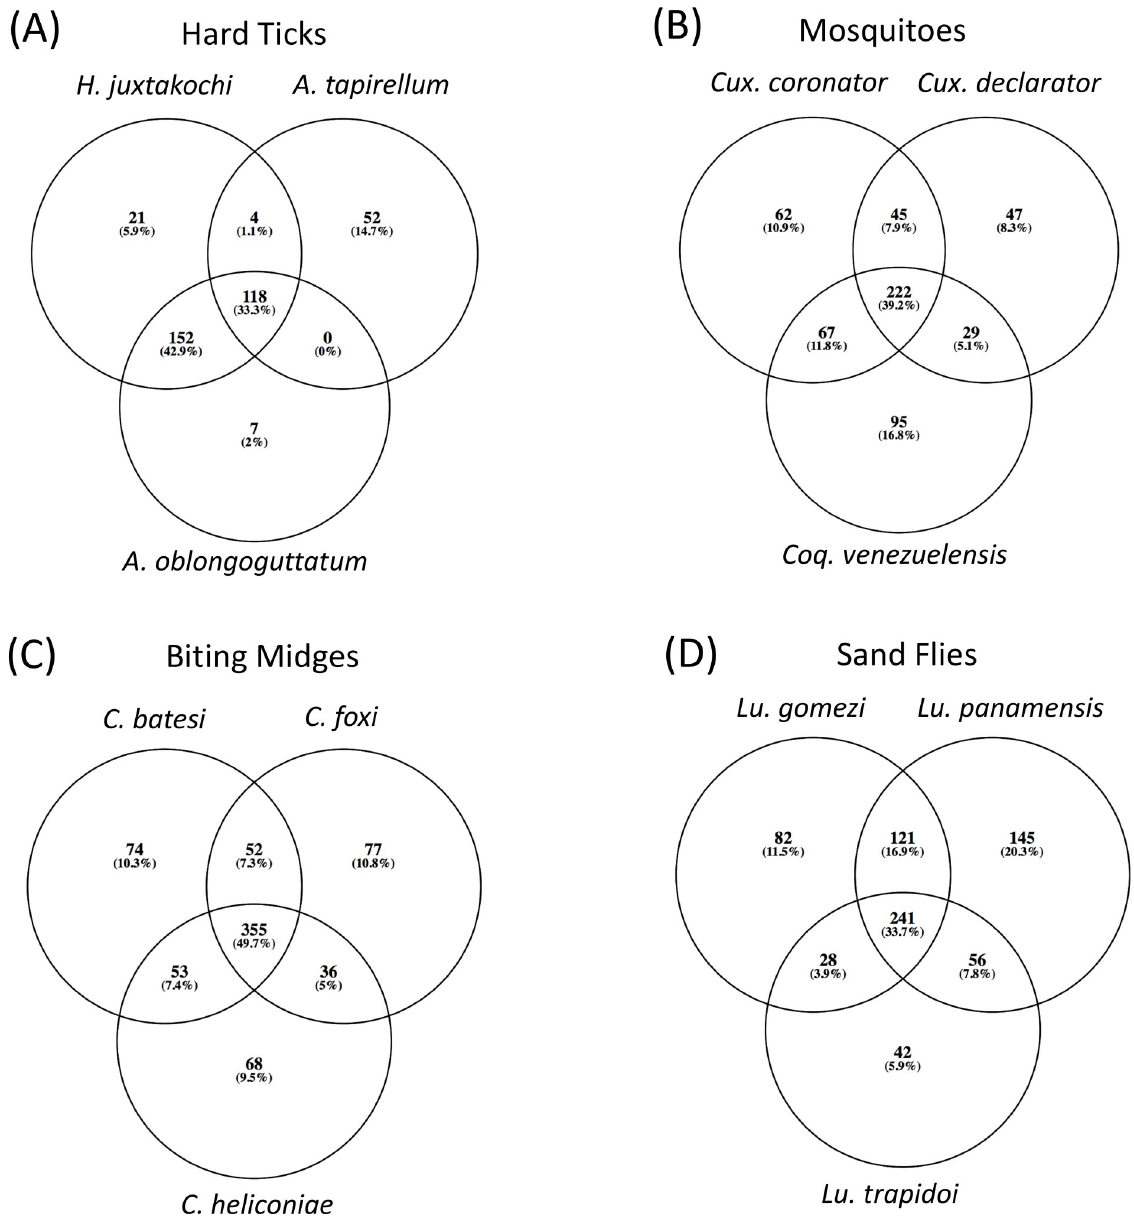
Fig 3. Venn diagram of shared and unique bacterial OTU’s among (a) three different species of Ixodidae; (b) two species of Culex (Culicidae) and one species of Coquillettidia (Culicidae); (c) three species of Culicoides (Ceratopogonidae); (d) three species of Lutzmyia (Psychodidae).